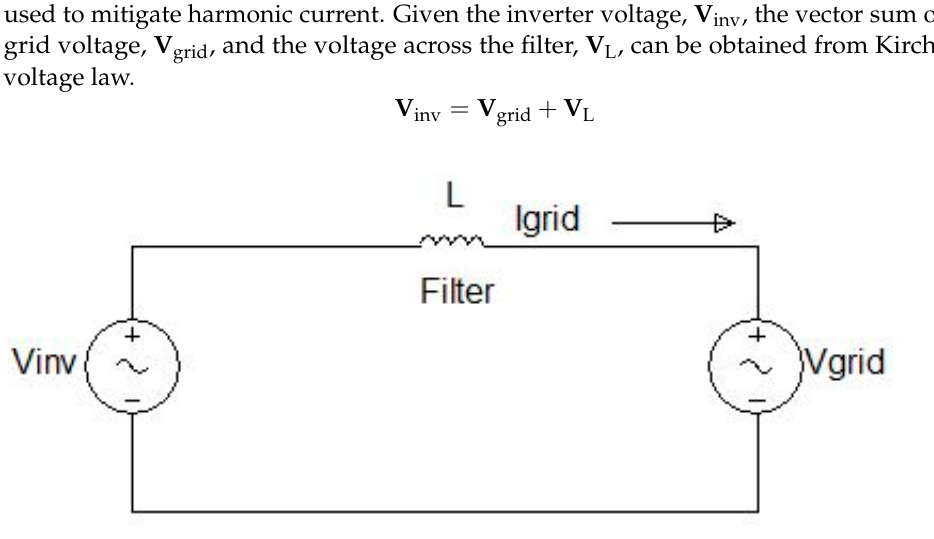
Figure 1. Equivalent circuit of a PV grid interphase.